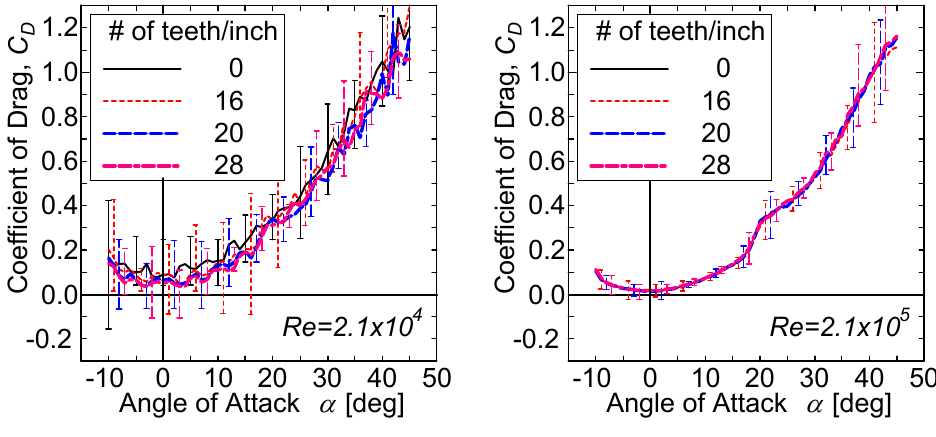
Fig.7(a) C D at U =2m/s, Re =2.1x10 4 Fig.7(b) C D at U =20m/s, Re =2.1x10